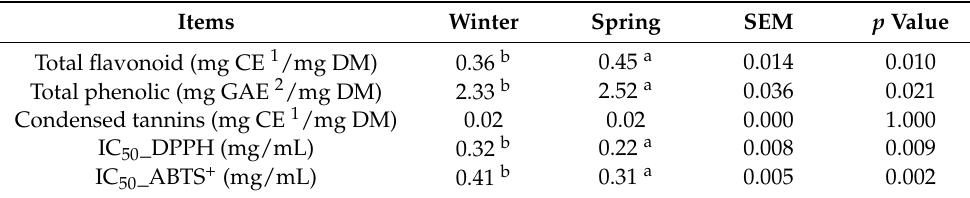
Table 2. Secondary metabolites of Paulownia shan tong harvested in winter and spring. Items Winter Spring SEM p Value Total flavonoid (mg CE 1 /mg DM) 0.36 b 0.45 a 0.014 0.010 Total phenolic (mg GAE 2 /mg DM) Condensed tannins (mg CE 1 /mg DM) 0.02 0.02 0.000 IC 50 _DPPH (mg/mL)